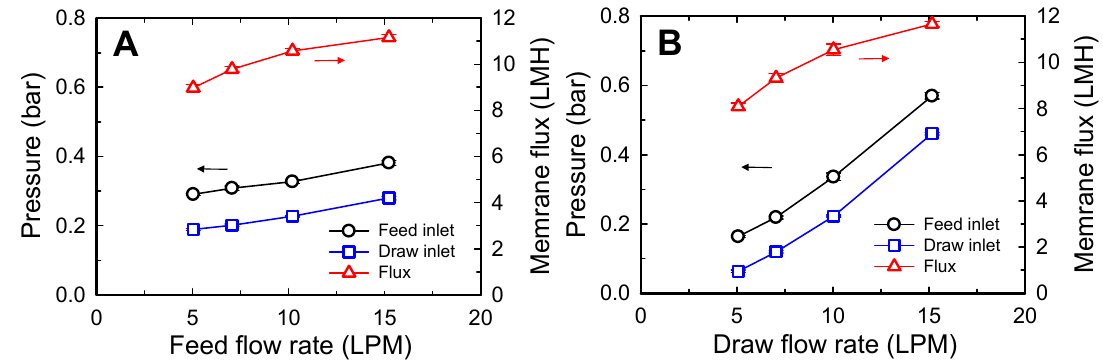
Figure 2. Effect of flow rates on inlet pressures and membrane flux of spiral-wound FO. ( A ) Feed flow rate was adjusted to 5, 7, 10, and 15 LPM with a constant draw flow rate of 10 LPM. ( B ) Draw flow rate was adjusted to 5, 7, 10, and 15 LPM with a constant feed flow rate of 10 LPM. The concentration of the feed and draw solutions were 10 and 58.4 g / L NaCl, respectively. One spiral-wound FO element (15.3 m 2 ) was used. The feed inlet pressure was adjusted to be 0.1 bar higher than the draw inlet pressure by using the backpressure valve on the feed side. The error bars represent one standard deviation.